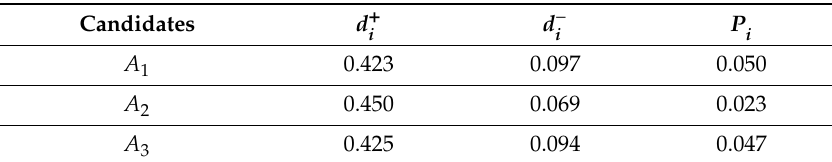
Table 2. An overview of the ranking of the